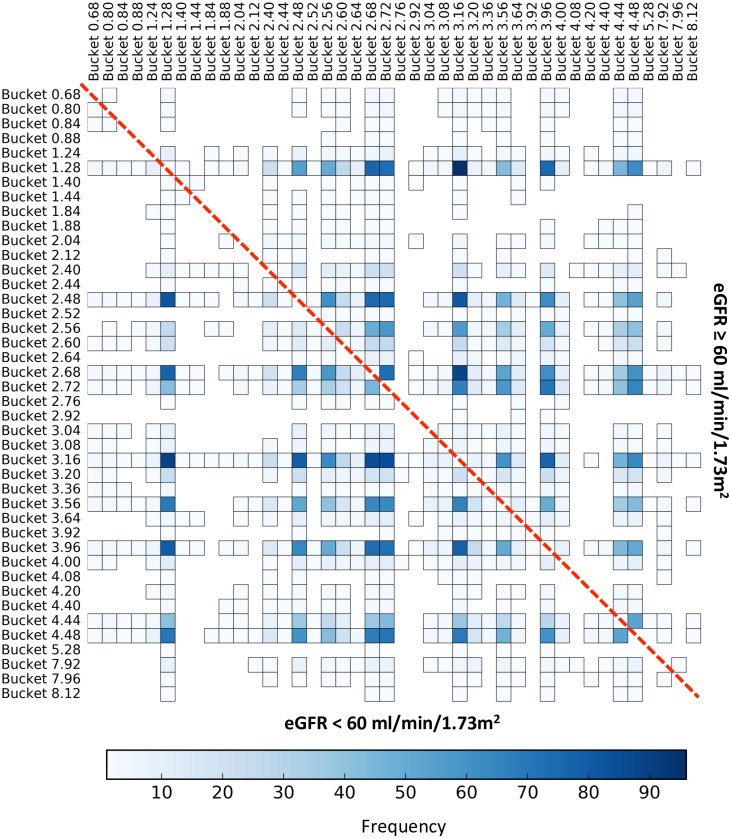
Frequency of the bucket interaction over the 100 metabolomic local 1&2D models.This figure shows the frequency heatmap of the interaction (color scale) of each bucket pair over the 100 local 1&2D models. The more robust the interaction is, the darker it will be. The interactions corresponding to the subgroup of patients with an eGFR < 60 ml/min/1.73m2 are displayed in the lower triangle and conversely, the interactions corresponding to the subgroup of patients with an eGFR ≥ 60 ml/min/1.73m2 are displayed in the upper triangle. The limit of the two triangles is represented by the red dashed-line.